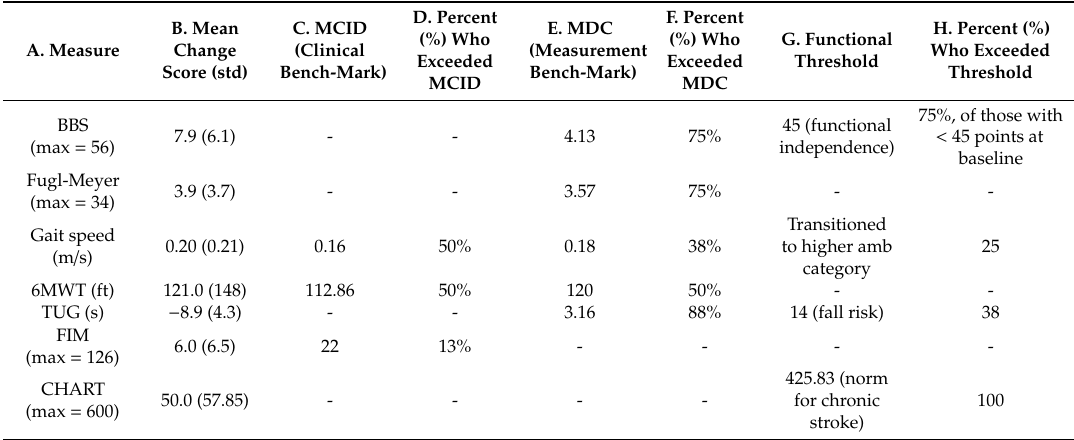
Figure 3. Change in lower extremity Fugl-Meyer score from baseline to 6 months. Key: Fugl-Meyer; (LE): Lower Extremity